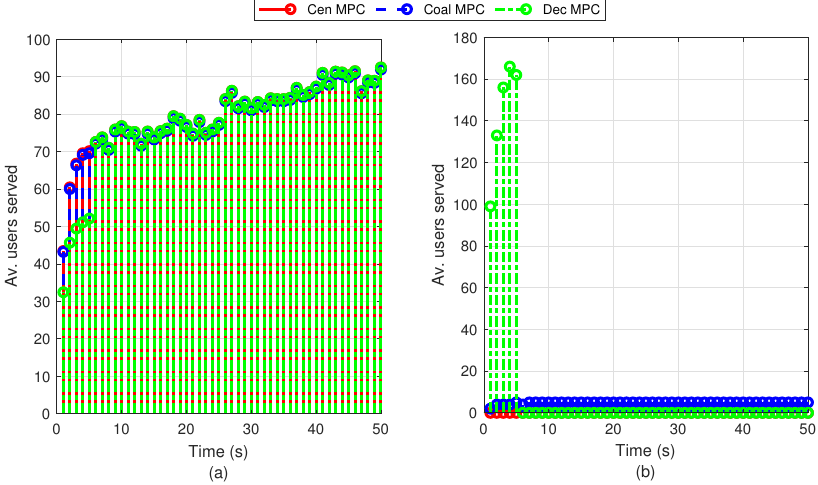
Figure 5. Average users served for the MPC-based methods in the 9-BS network: ( a ) SCBSs, and ( b )